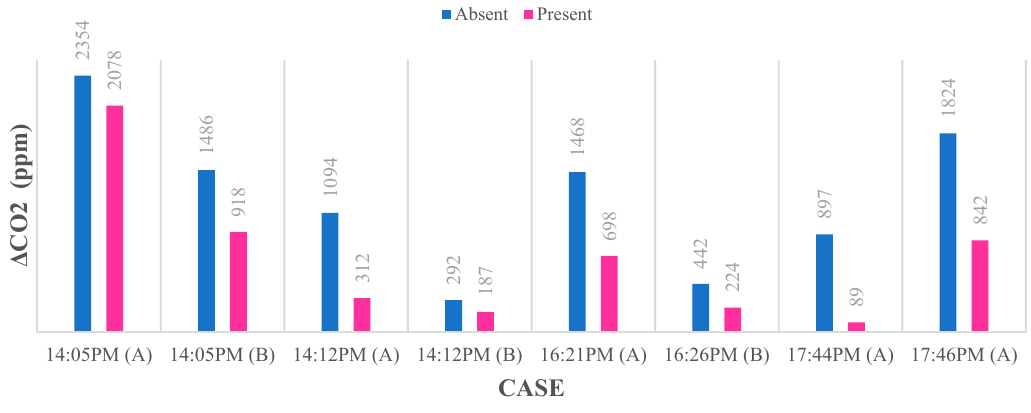
Figure 5. CO 2 concentration with or without plants.